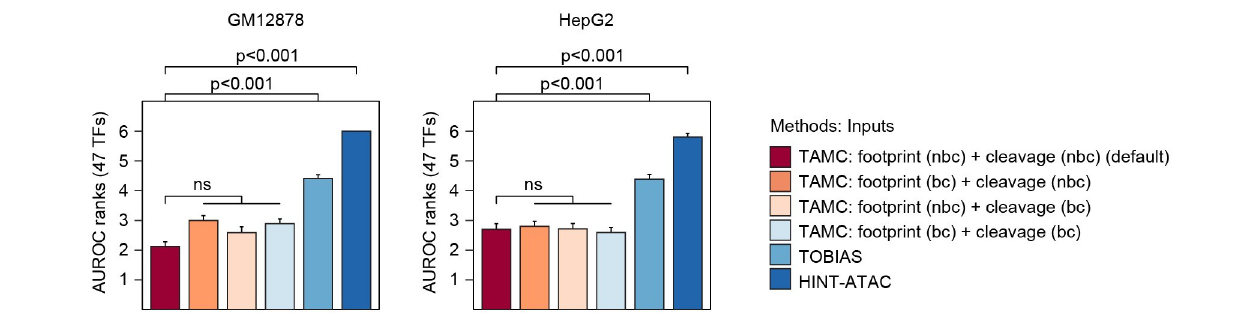
Fig 3. TAMC performance is independent of bias correction. Bar graphs compare intra-data classification performance of TAMC models using four different combinations of bias-corrected and uncorrected inputs together with TOBIAS and HINT-ATAC in GM12878 and HepG2 cells. The performance of models within each graph were ranked from 1 to 6 for each TF. The higher AUROC is, the lower the rank number. Average AUROC ranks for 47 TFs for each method/model were shown and the error bars represent SEM. Difference between the performance of default TAMC and the other models were examined using Friedman-Nemenyi test and p-values for significant differences are indicated. Complete statistic test results are provided in S3 Table. bc, bias corrected; nbc, non-bias corrected; ns, non-significant. https://doi.org/10.1371/journal.pcbi.1009921.g003 PLOS Computational Biology | https://doi.org/10.1371/journal.pcbi.1009921 September 12,